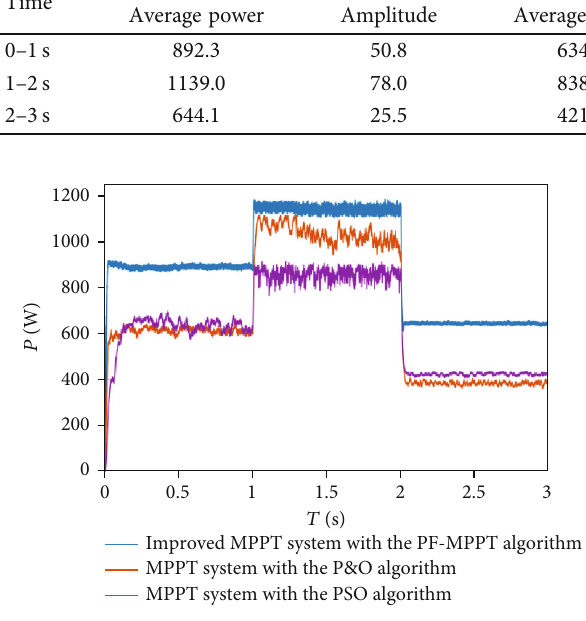
Figure 21: Simulation results of output